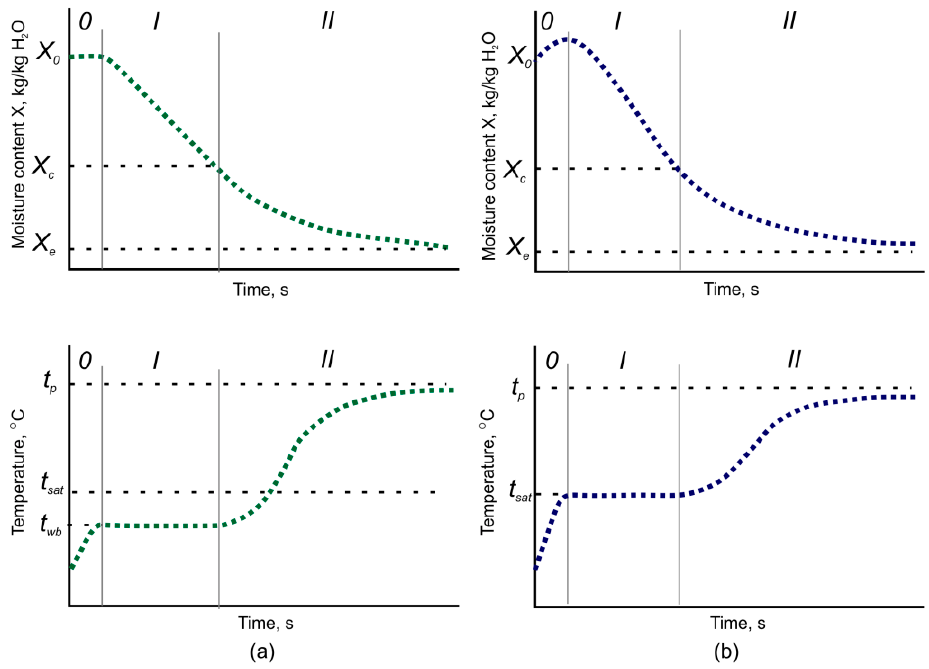
Figure 1. Drying stages: ( a ) hot-air drying (green dotted line); ( b ) SHS drying (blue dotted line) (Based on [25]).